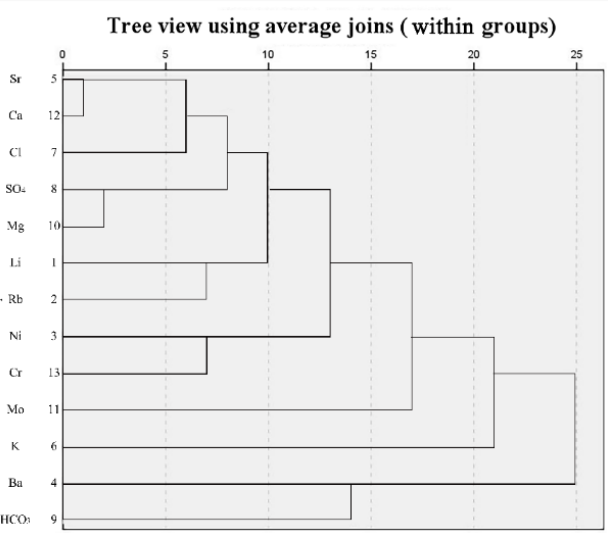
Figure 16. Cluster analysis of different trace elements and conventional ions in the mining area.